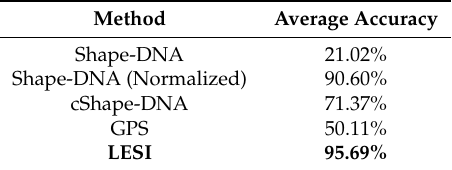
Table 2. Classification accuracy using McGill